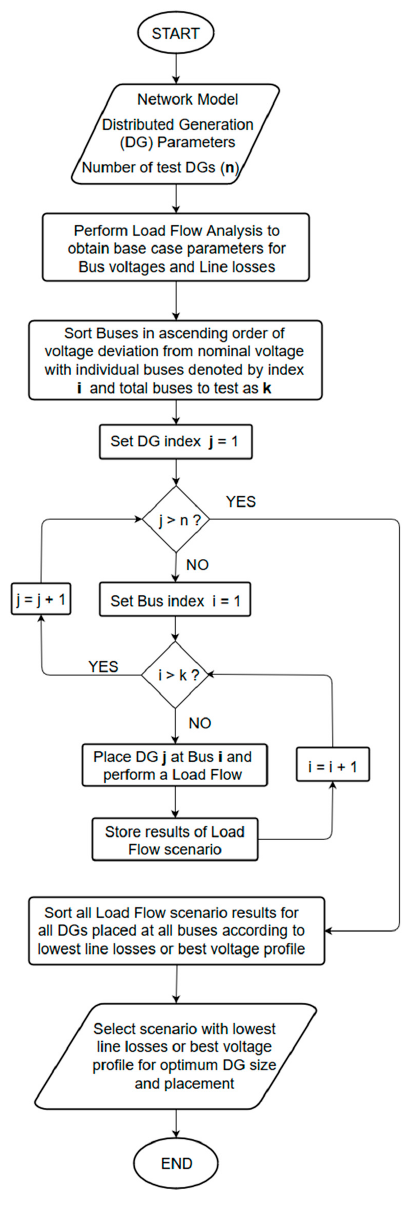
Figure 1. The flow chart of the proposed decision-making algorithm.